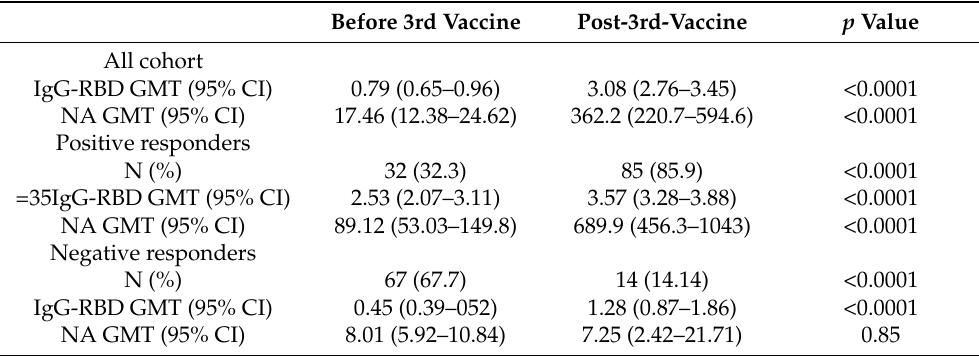
Table 2. Univariate analysis of immune status before the third vaccine vs. post-third-vaccine in RTR according to the study of Hod et al. [13].